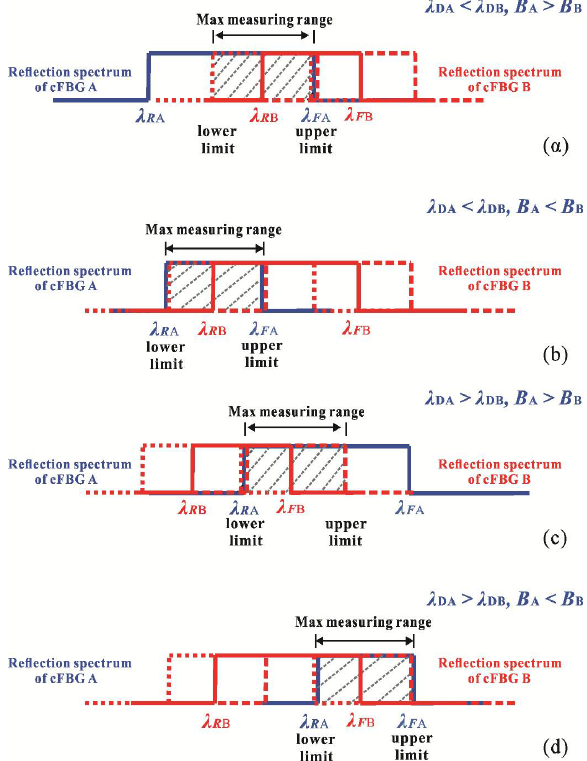
Figure 3. The maximum spectrum range that can be used for measurements when the wavelength of cFBG B shifts to the long wave direction ( a ) for λ DA < λ DB and B A > B B , ( b ) for λ DA < λ DB and B A < B B , ( c ) for λ DA > λ DB and B A > B B , and ( d ) for λ DA > λ DB and B A < B B . Table 1. Wavelength-shift condition of the upper limit and lower limit of the reflected power. Center FWHM Wavelength-Shift Light Power Wavelength Condition Condition